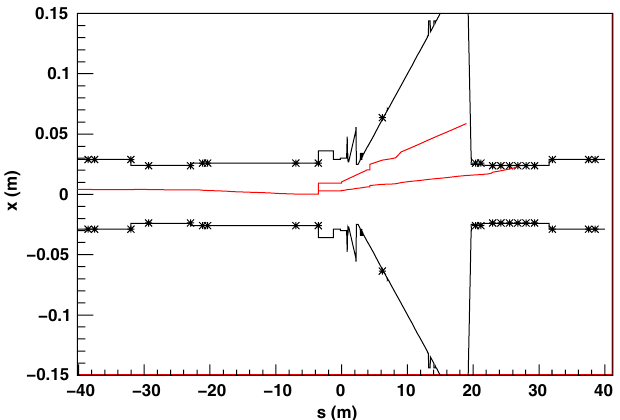
FIG. 7. (Color) The range of compensation dipole corrector (MBXWH) settings which are dangerous for the LHCb beam pipe and interaction region magnets for beam 1 and excess current in the magnet. On this plot s ¼ 0 corresponds to the interaction point and the center of the experimental cavern.